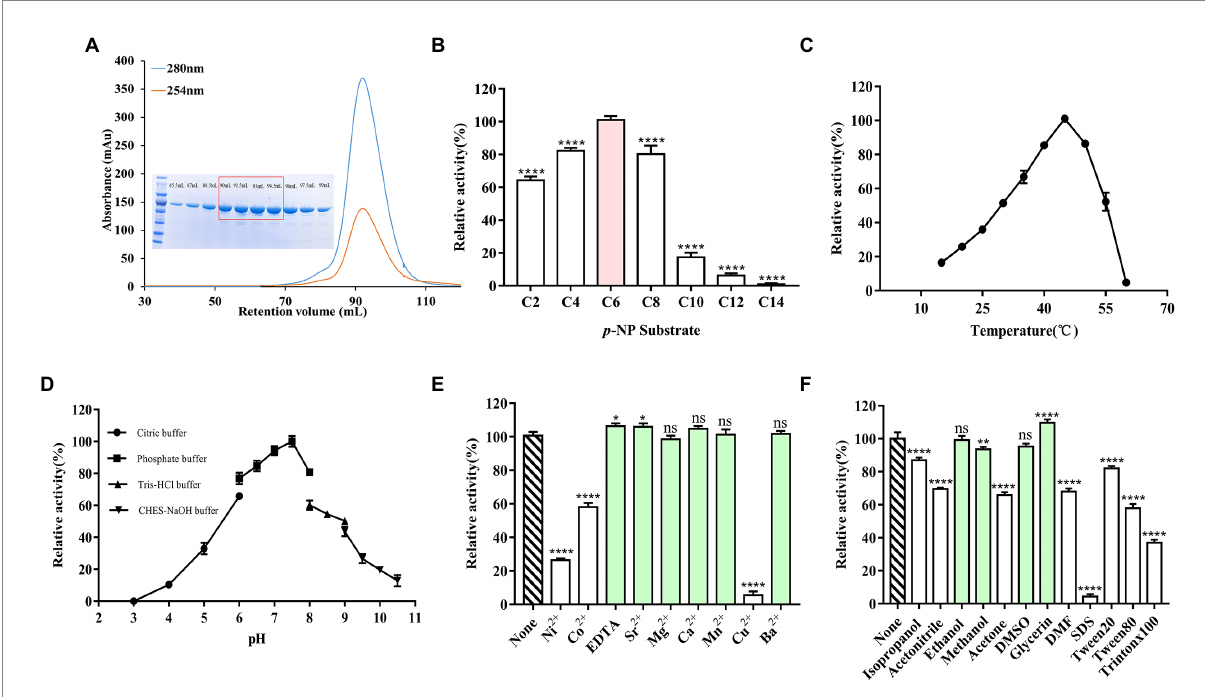
FIGURE 2 Catalytical features of E93 with p -NP esters as substrates. (A) Gel filtration chromatography and SDS-PAGE results of E93. High-purity protein samples were collected for crystallization (in the red box). (B) Enzymatic activities to substrates with various fatty acid chain of p -Nitrophenyl ( p -NP) esters. The catalytic activity of E93 to p -NP hexanoate (C6) was 100%. (C) Effects of temperature on enzyme activities. Enzymatic activities were measured in a series of temperatures. The activity obtained at 45 ° C was taken as 100%. (D) Effects of different pH on enzyme activities. Enzymatic activities were determined under a series of pH. The activity obtained at pH 7.5 was taken as 100%. (E) Tolerance of ions. The reaction without additional ions was used as a control. The C6 substrate was used for measurements. (F) Effects of organic solvents on the enzymatic activity. The reaction without any organic solvent was used as a control. The solvents with no inhibition effect on the enzyme activity were labeled with light green color in panels (E,F) . The data showed in panels (B–F) is from triplicate experiments (mean ± SD). * p < 0.05, ** p < 0.01, *** p < 0.001, **** p < 0.0001, and ns, not